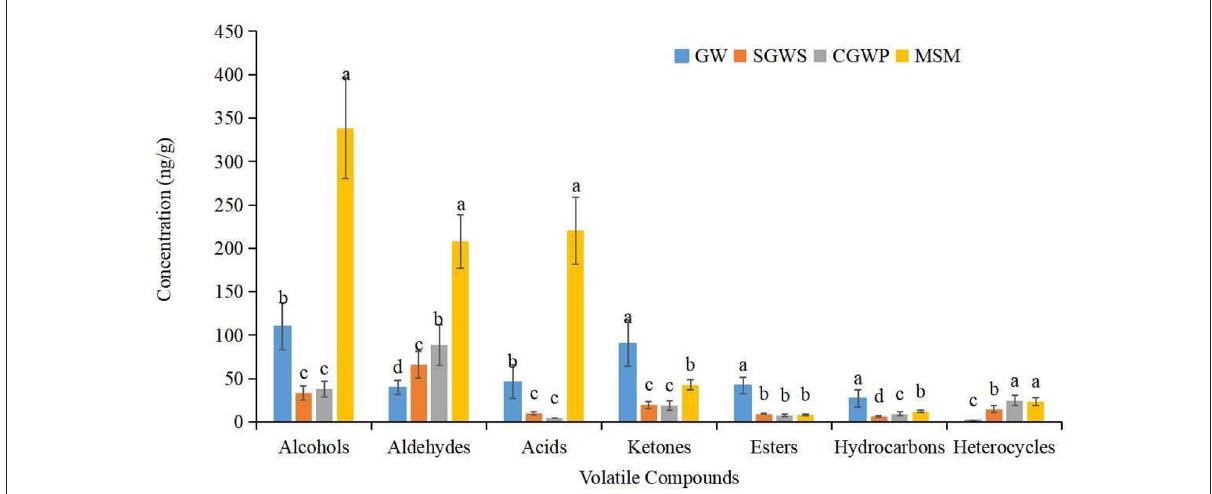
FIGURE7 Changes in the content of different types of volatile compounds in nian zhuan at different processing stages.